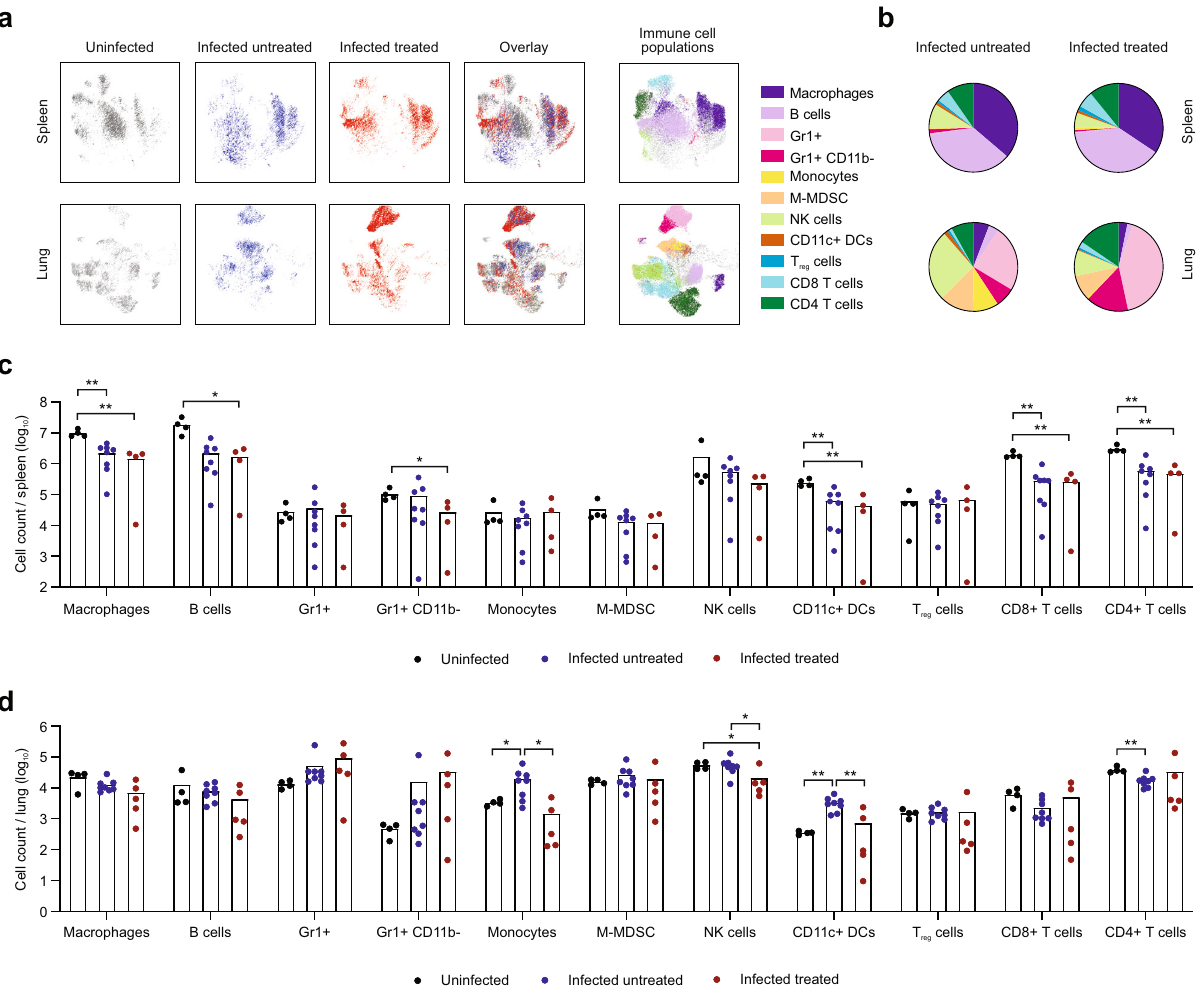
Fig. 4 Effects of SFN treatment in the immune response. a Uniform Manifold Approximation and Projection (UMAP) was used to visualize all the immune cell populations within the spleen and lung of uninfected (grey), infected untreated (blue), and infected treated (red) mice. The corresponding immune cell populations are presented in multiple colors in the panels on the right ( b ). Summary of immune cell frequencies out of total CD45 + immune cells in spleen and lung of infected treated or untreated mice. c Total cell count of indicated immune cell subset per spleen. Each dot represents one mouse. d Total cell count of indicated immune cell subset per lung. Each dot represents one mouse, data from one independent experiment. Bars represent mean values. DCs, dendritic cells; NK, natural killer, M-MDSC, mononuclear myeloid-derived suppressor cells. Statistical comparisons were made with two-way ANOVA, * P < 0.05, ** P <